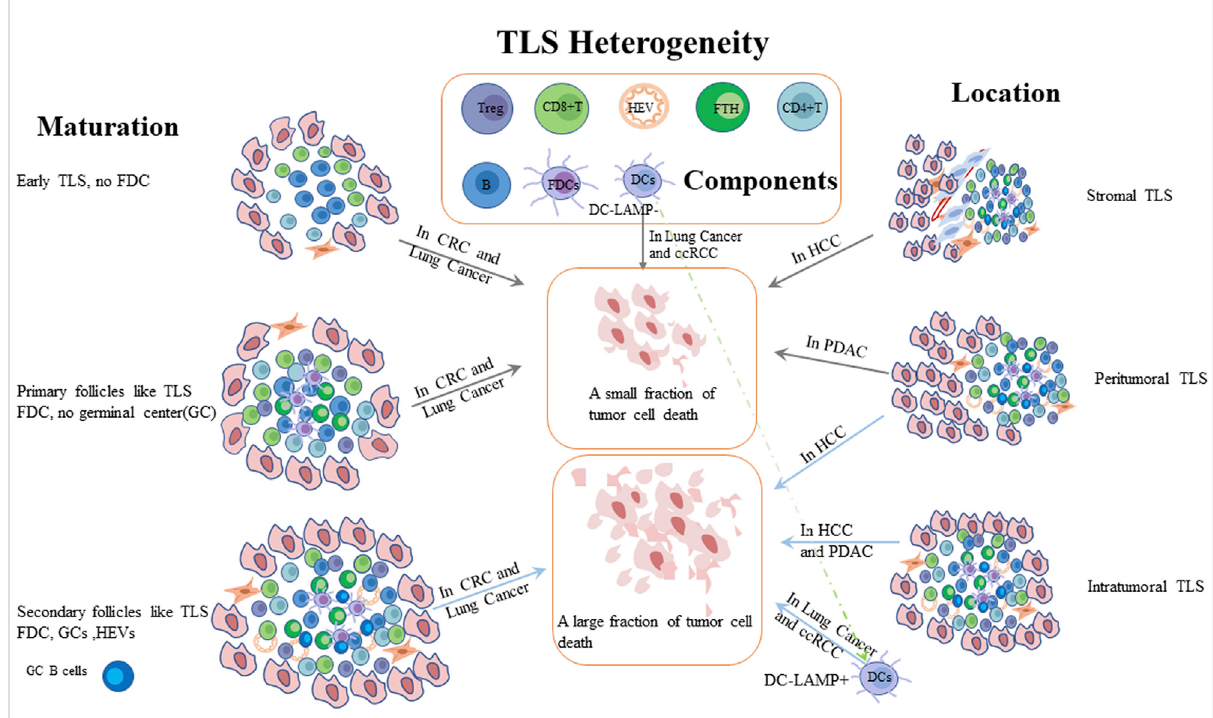
FIGURE 1 Patients with cancer have different prognosis due to TLS heterogeneity. Compared to stromal TLS, intratumoral or both intratumoral and peritumoral mature TLSs were associated with a better prognosis in different tumors. TLSs with GCs have been shown to kill tumor cells more effectively than immature TLS. PDAC: pancreatic ductal adenocarcinoma; HCC: hepatocellular carcinoma; CRC: colorectal cancer; ccRCC: clear cell renal cell carcinomas; DC-LAMP: Dendritic dendritic Cell cell Lysosomelysosome- – Associated associated Membrane membrane Proteinprotein; FDC: follicular dendritic cells; HEV: high endothelial